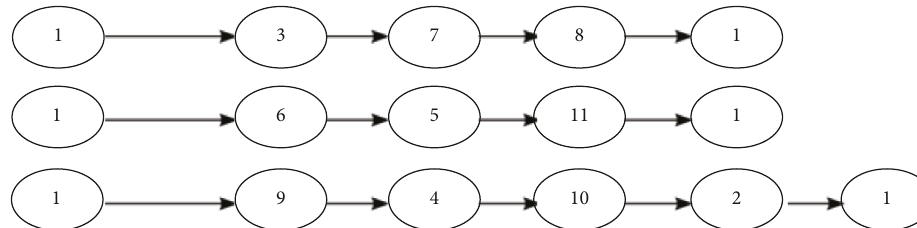
Figure 2: Details of the routes formed in the first period.